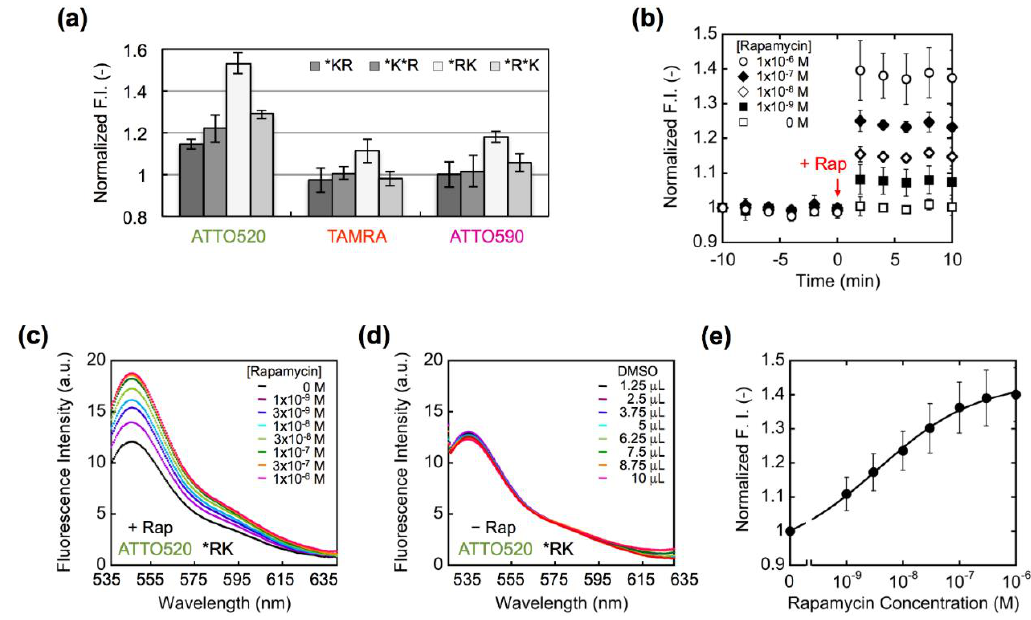
Figure 4. ( a ) Comparison of the fluorescence responses of Q’-body upon addition of 1 μM rapamycin. Error bars represent ±1 SD ( n = 3). ( b ) Fluorescence time-course of ATTO520-incorporated *RK type Q’-body after adding rapamycin. ( c ) Fluorescence spectra of ATTO520-incorporated *RK type Q’-body in the presence of rapamycin at indicated concentrations. ( d ) The same as in (c) except that DMSO, the solvent of rapamycin, was added. ( e ) Rapamycin concentration-dependent fluorescence increase of ATTO520-incorporated *RK type Q’-body Error bars represent ±1 SD ( n =